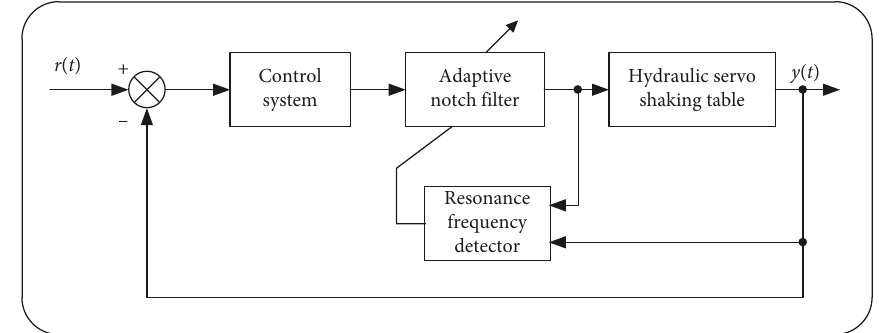
Figure 6: Schematic diagram of the resonance